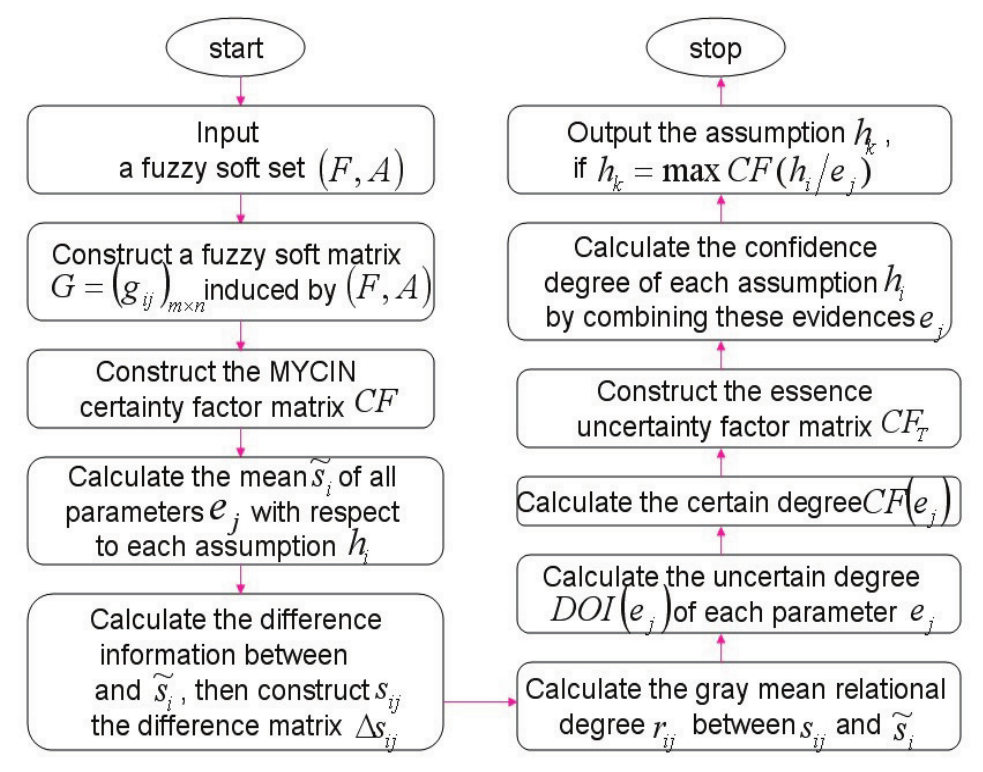
Figure 1: Flow chart of